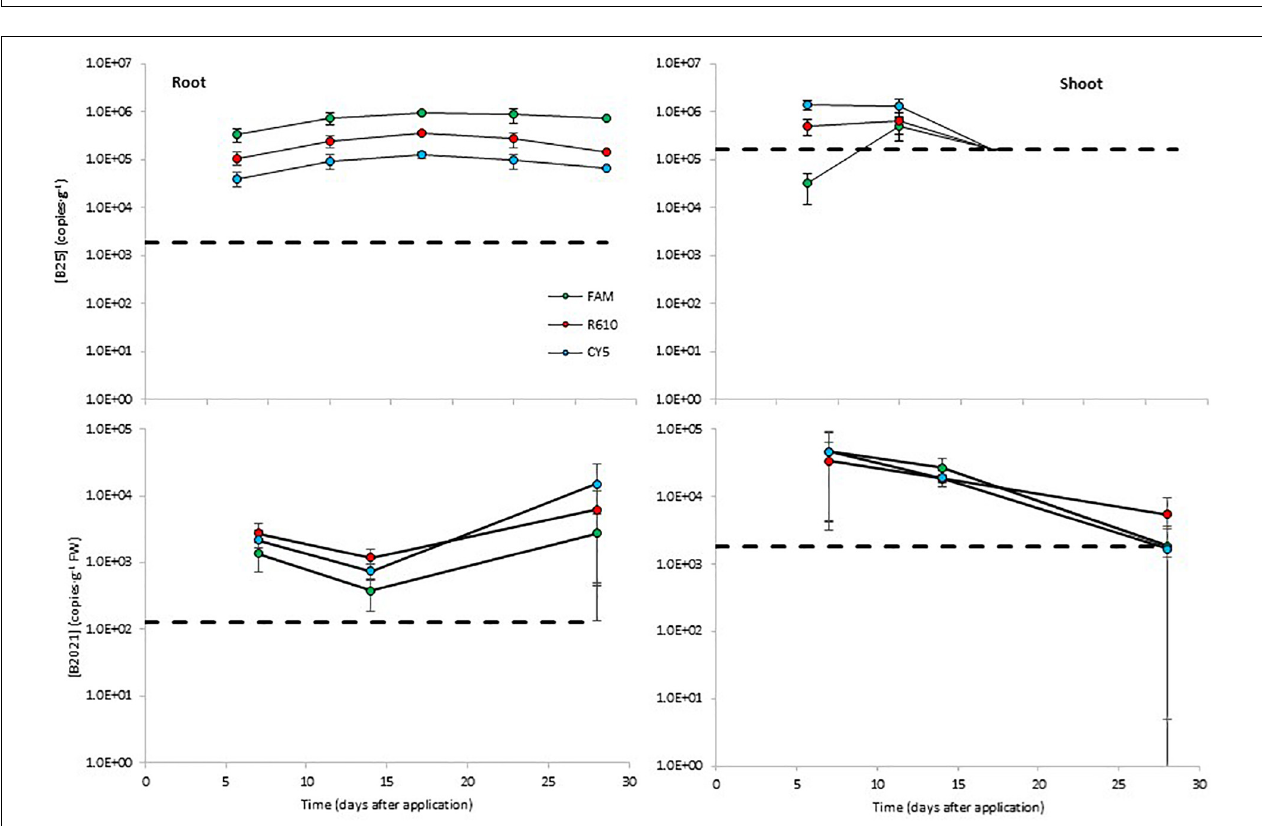
FIGURE 4 | Colonization of potato plant tissues by the biocontrol bacterial strains B25 and B2021 (B2017 was not detected over the limit of detection of 2.6 × 10 5 copies · g − 1 FW). Bacterial concentrations were measured with three markers per strain, labeled with different fluorophores (FAM, CY5, and R610 [LightCycler Red 610]). The dashed lines represent the limits of detection; data points below detection limits are omitted. Negative controls (untreated plants) yielded concentrations below detection limit in all cases (not